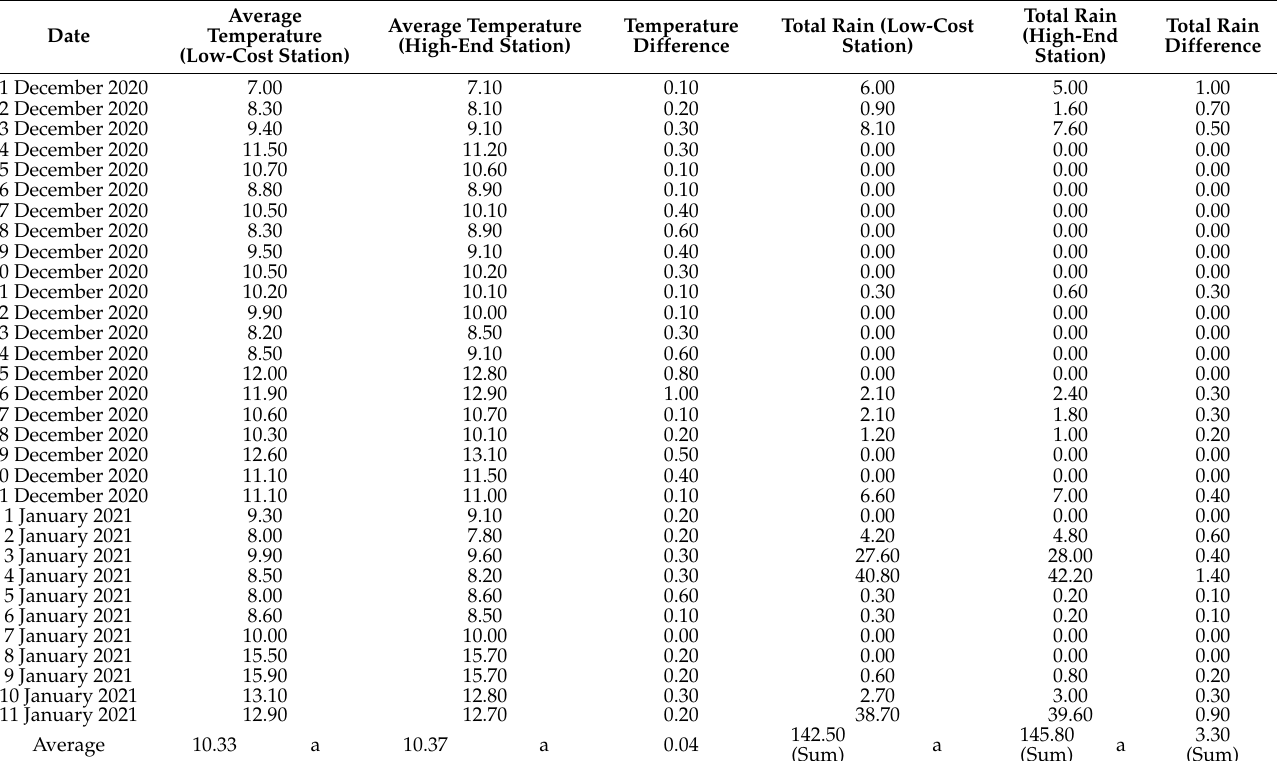
Table 2. Comparison of measurements between the low-cost and high-end weather stations. Different letters accompanying monthly means and monthly sum values of each distinct measurement type (temperature and total rain) for each set of the industrial and low-cost sensors indicate a significant difference between the measurements, based on a Fisher’s least significance difference test ( p <